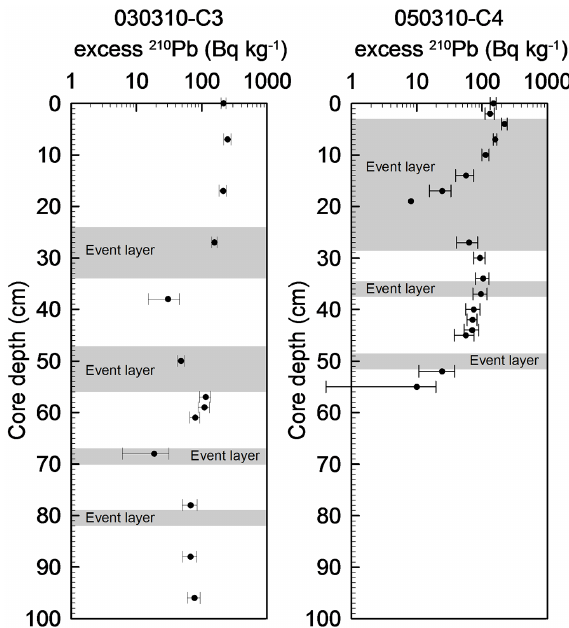
Figure 4. Excess 210 Pb activity profiles with 2 σ uncertainty ranges observed in the shallow water cores 030310-C3 and 050310-C4.